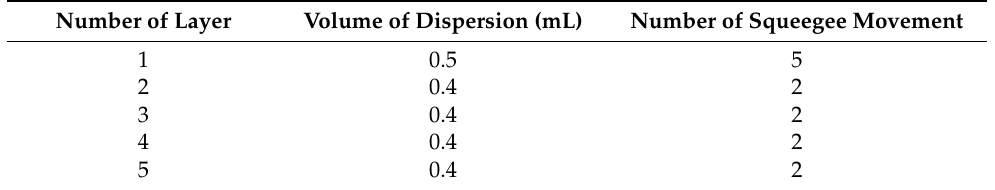
Table 2. Parameters of screen printing on CO fabric using CNTs/CNC—1:1 and CNTs/CNC—1.5:1.5. Number of Layer